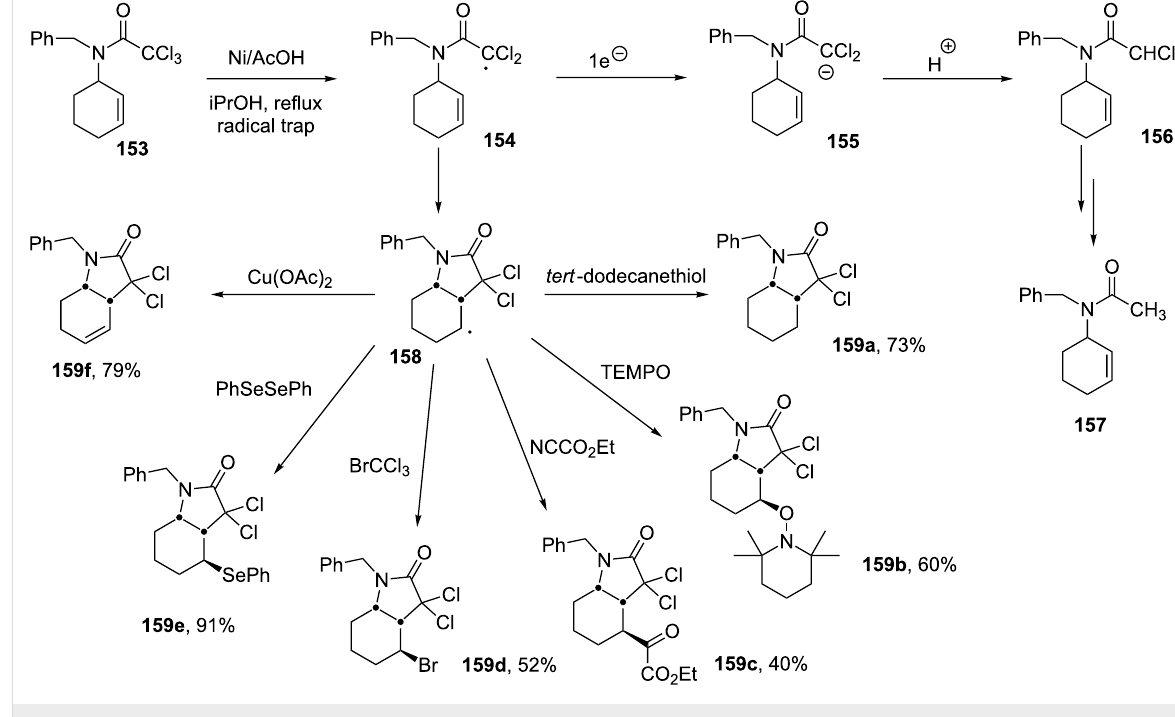
Scheme 29: Synthesis of variously substituted lactams.